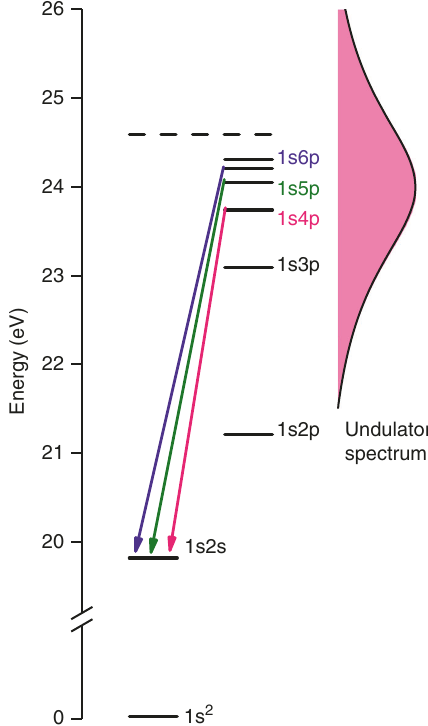
Fig. 2 Energy level diagram of He states. Fluorescence transitions selected in the measurements of the spectra in Fig. 3b are presented. The undulator spectrum has a bandwidth of about 10% of the central photon energy of around 24 eV, which covers resonances for the excitations of a 1 s electron into many p-type Rydberg orbitals